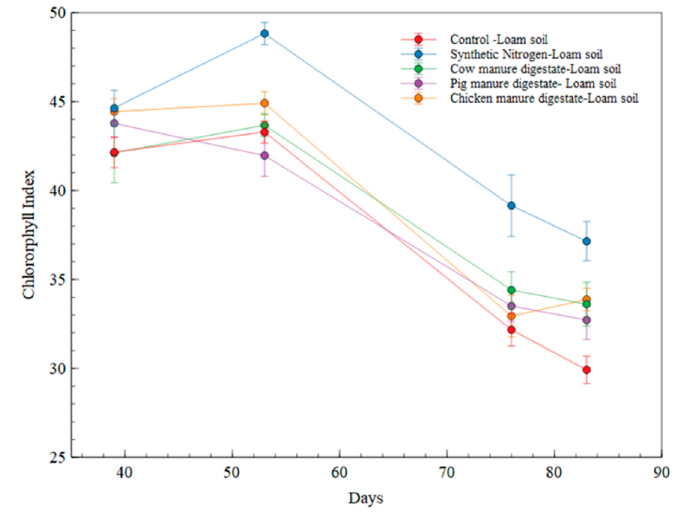
Figure 6. Chlorophyll Index measurement in loam soil fertilized treatments. In comparing digestates treatment in the two soil types, chlorophyll index was higher in the loam soil across all the digestates than that of the sandy loam soil. Cow manure digestate and chicken manure digestate in sandy loamy soil had the lowest chlorophyll index throughout the measurement period (as illustrated in Figure 7).